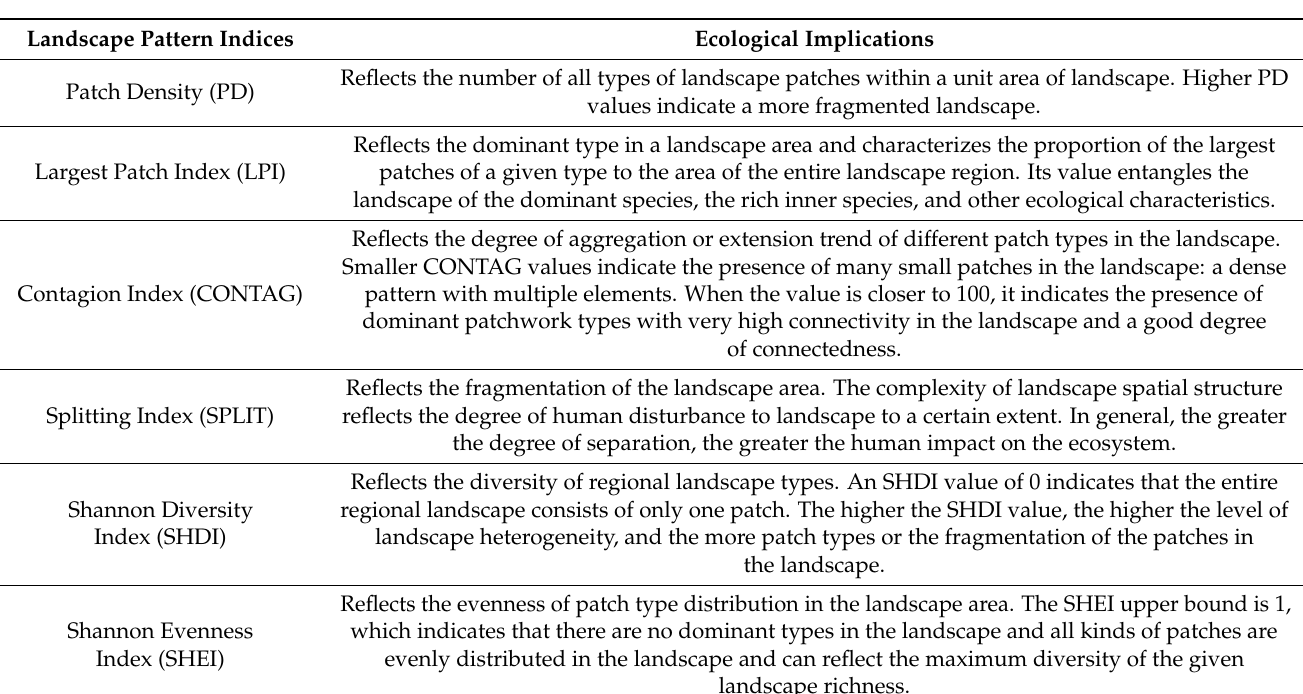
Table 1. Landscape pattern indices and their ecological implications